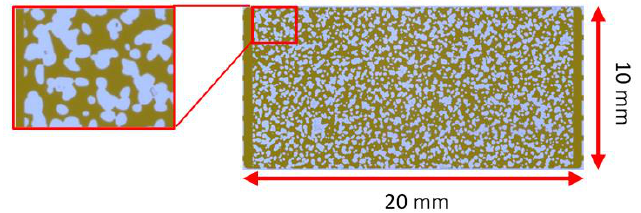
Figure 1. Pore-network of the glass micromodel used in this study (Blue: grain area; brown: pore area).